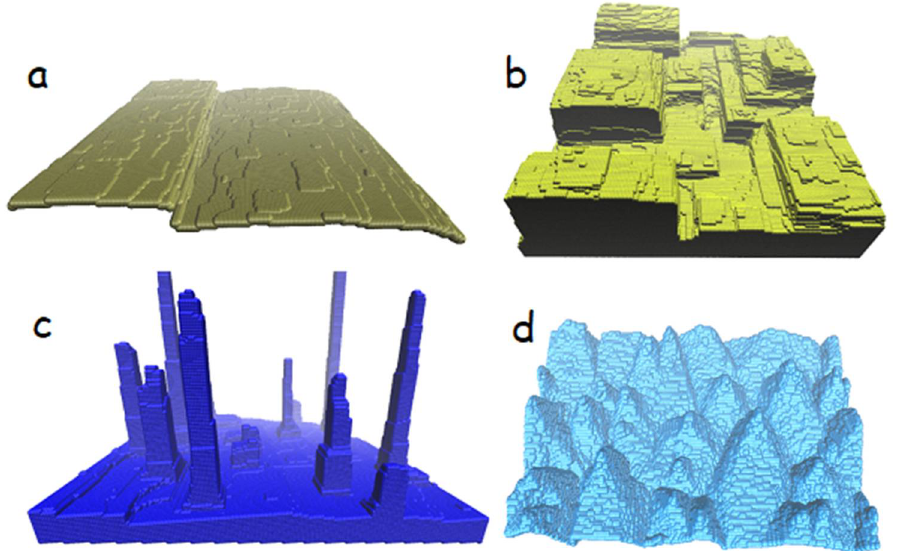
Figure 5. ( a ) Antibunches, c 0 = 0.02, P iES = 0.2, P dES = 0.6, p w = 1.66, l 0 = 10, n DS = 10, time steps 3 × 10 6 . ( b ) Nanopillars, c 0 = 0.02, P iES = 0.2, P dES = 0.4, p w = 2.5, l 0 = 10, n DS = 10, time steps 2 × 10 5 . ( c ) Nanowires, c 0 = 0.02, P iES = 0.1, P dES = 0.2, p w = 5, l 0 = 10, n DS = 10, time steps 3 × 10 5 . ( d ) Pyramids, c 0 = 0.02 , P iES = 1.0, P dES = 0.0, p w = 1.0, l 0 = 5, n DS = 10, time steps 4 × 10 5 .